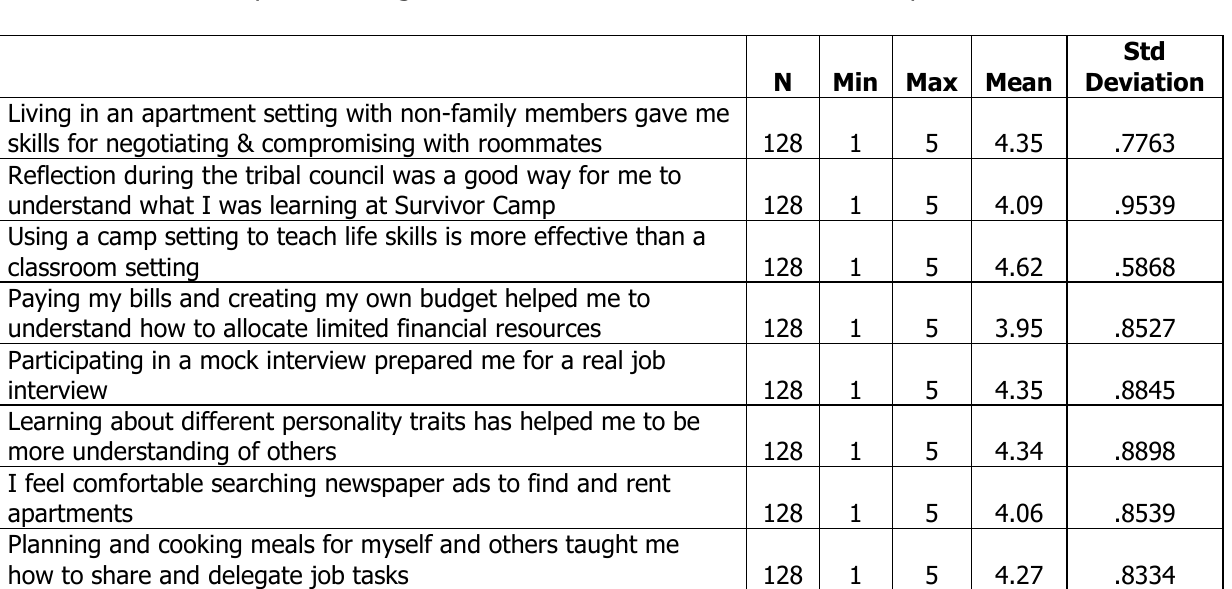
Participants’ Rating of the Effectiveness of the Survivor Camp Model